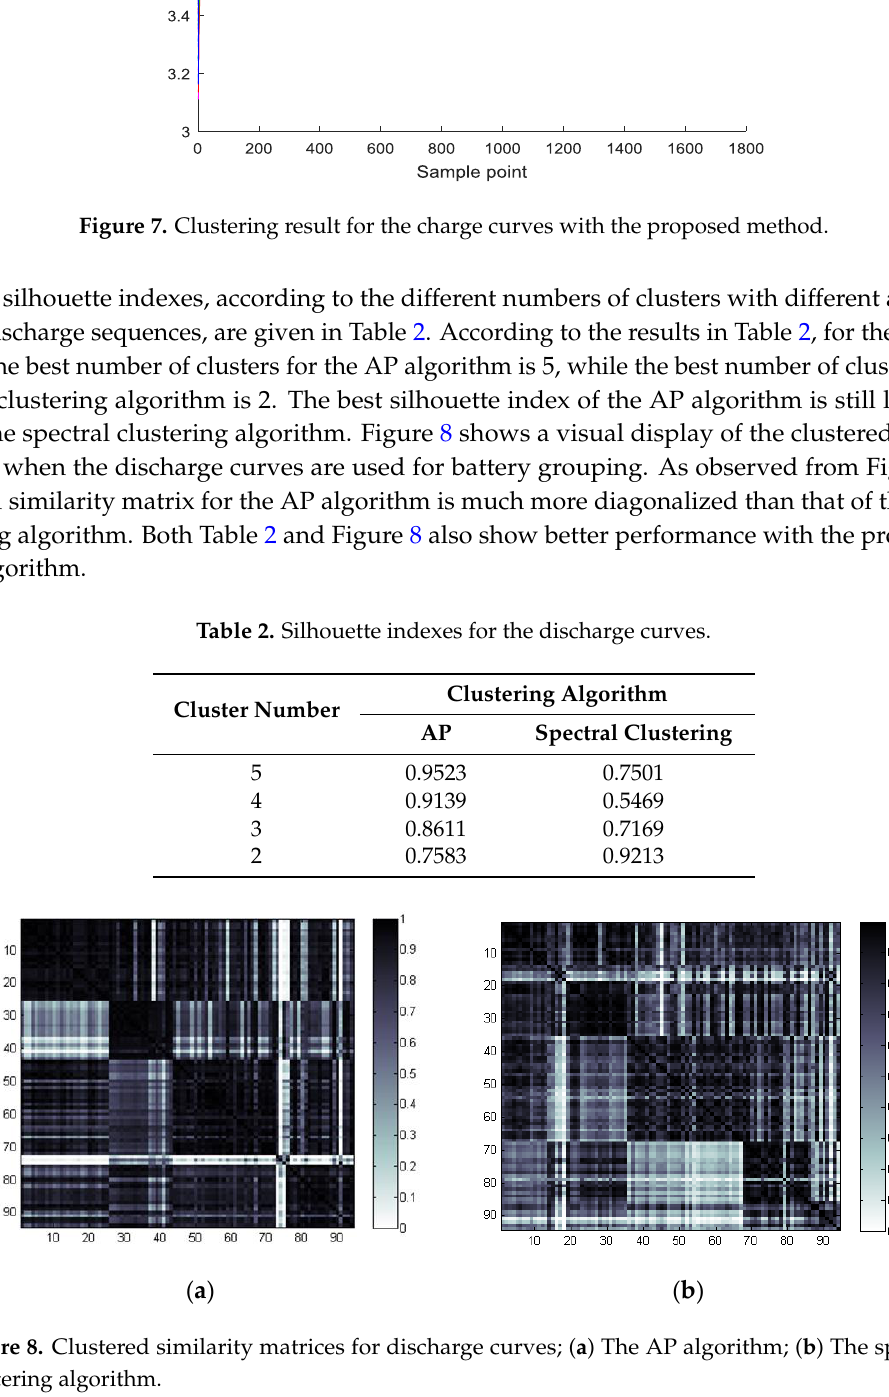
Figure 8. Clustered similarity matrices for discharge curves; ( a ) The AP algorithm; ( b ) The spectral clustering algorithm. Table 2. Silhouette indexes for the discharge curves.